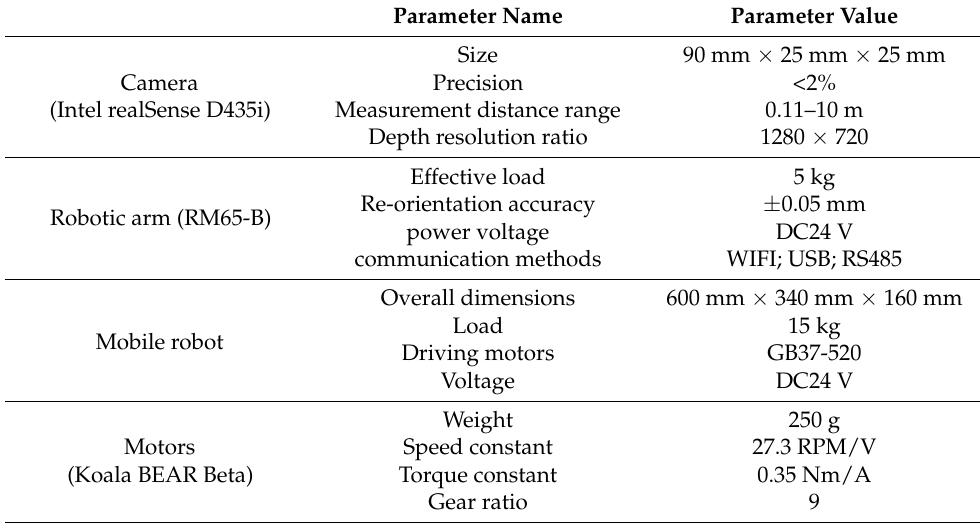
Figure 1. Structural layout of mobile robot. Table 2. Main equipment parameters.